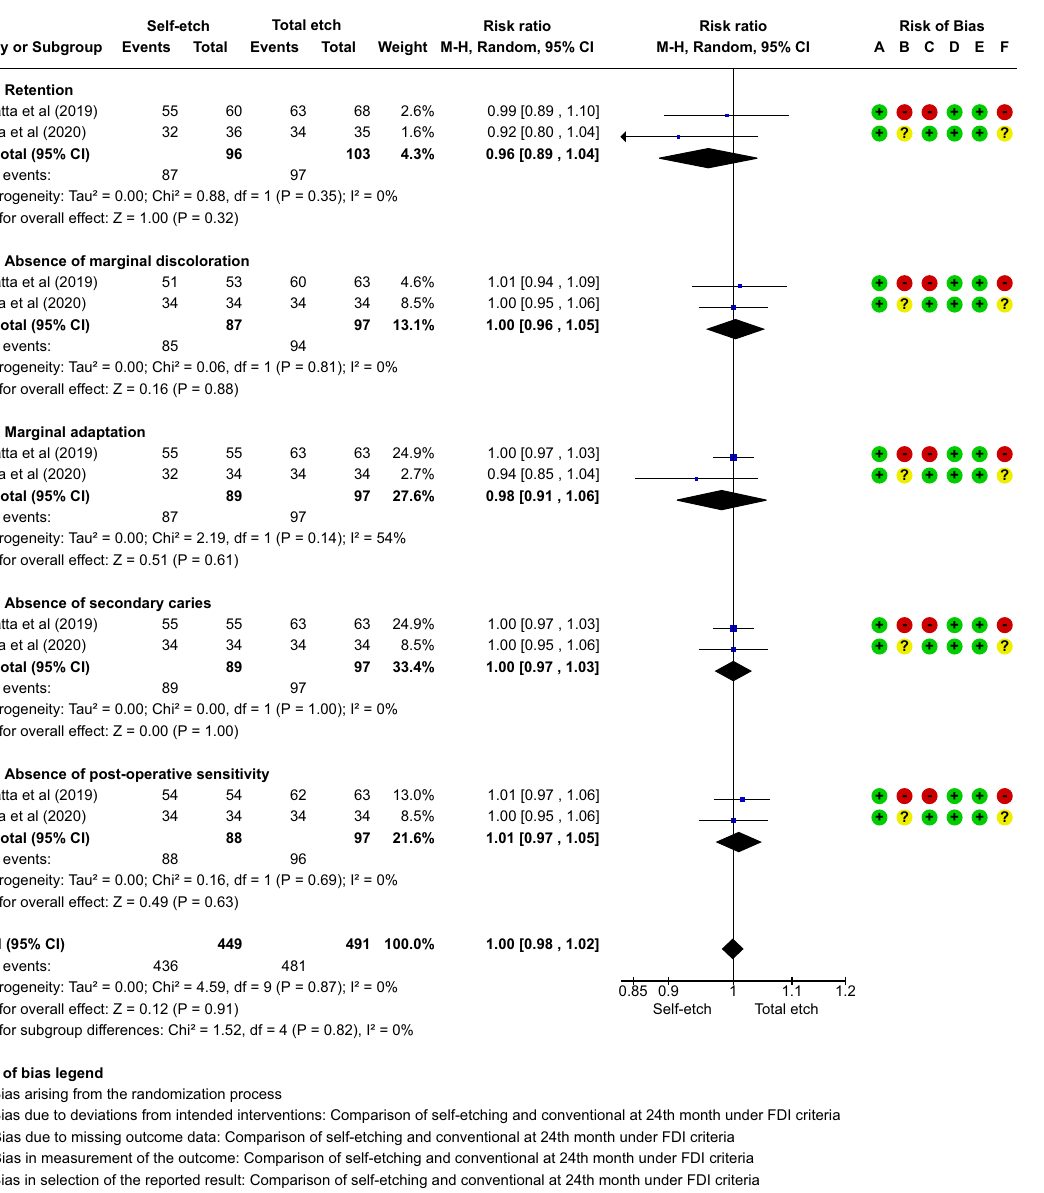
(B) Bias due to deviations from intended interventions: Comparison of self-etching and conventional at 24th month under FDI criteria (C) Bias due to missing outcome data: Comparison of self-etching and conventional at 24th month under FDI criteria (D) Bias in measurement of the outcome: Comparison of self-etching and conventional at 24th month under FDI criteria (E) Bias in selection of the reported result: Comparison of self-etching and conventional at 24th month under FDI criteria (F) Overall bias: Comparison of self-etching and conventional at 24th month under FDI criteria Fig. 7 Forest plot representing the pooled events at 24 months using FDI criteria. No signi fi cant difference observed between total etch and self-etch adhesive strategies for any of the parameters.